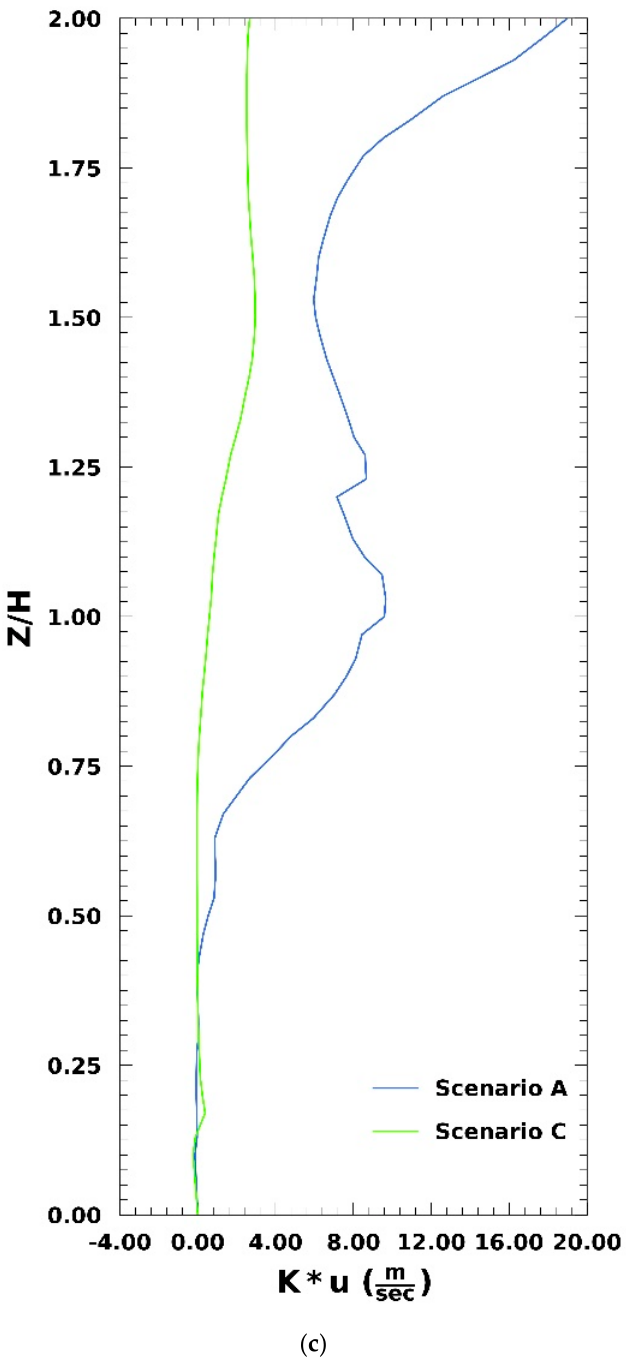
Figure 14. Concentration flux profiles that are due to the x − velocity component on the symmetry plane for Scenarios A and C at positions ( a ) (X: 7 H, Y: 5.5 H), ( b ) (X: 7.2 H, Y: 5.5 H), and ( c ) (X: 7.4 H, Y: 5.5 H) for heights Z that extend from 0 to 2 H.